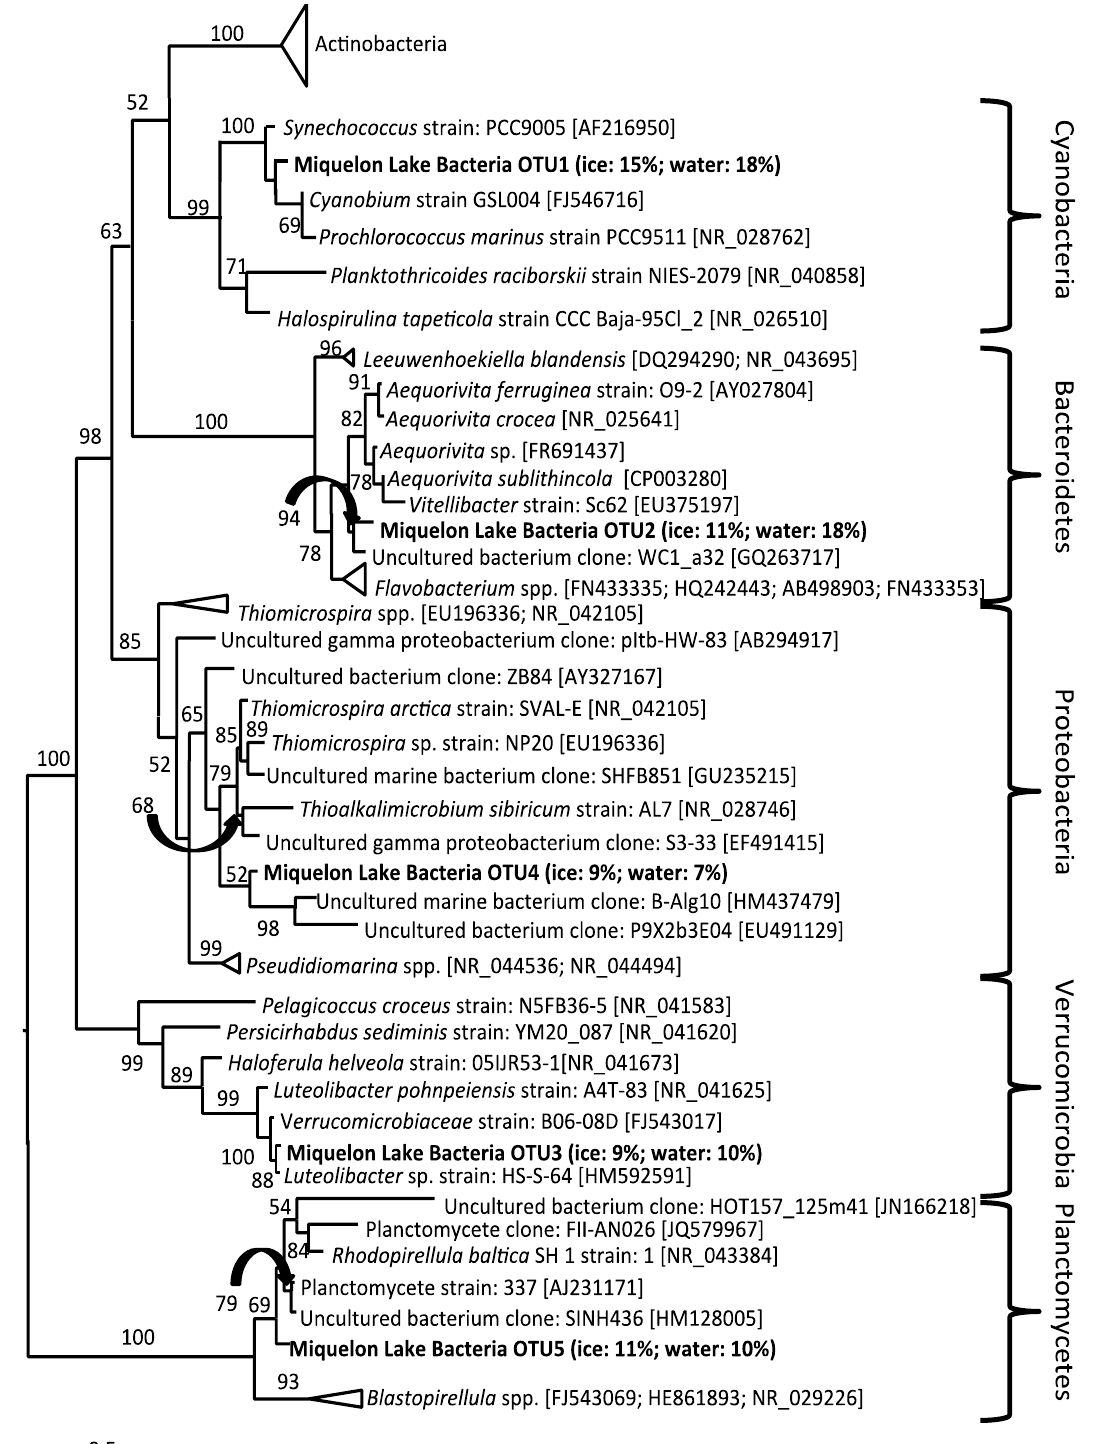
Figure 7. Maximum likelihood phylogenetic tree of Bacteria 16S rRNA genes from Miquelon Lake water and ice and relatives from the Genbank database. Scale bar represents 1 nucleotide change for each 10 nucleotides of sequence. Bootstrap support greater than 50 (of 100 replicates) is shown at nodes. Accession numbers for publically available sequences are given in parentheses. Miquelon Lake OTU are shown in bold; the relative abundance in the ice and water clone libraries is shown in